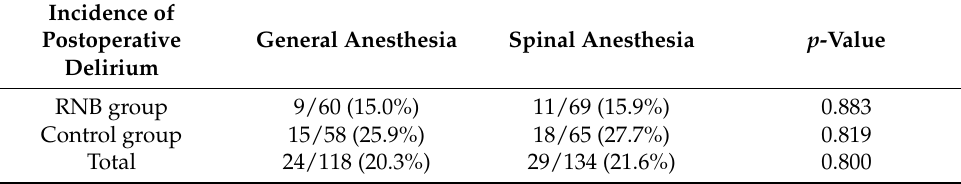
Table 4. Subgroup analysis for the incidence of delirium between general and spinal anesthesia.